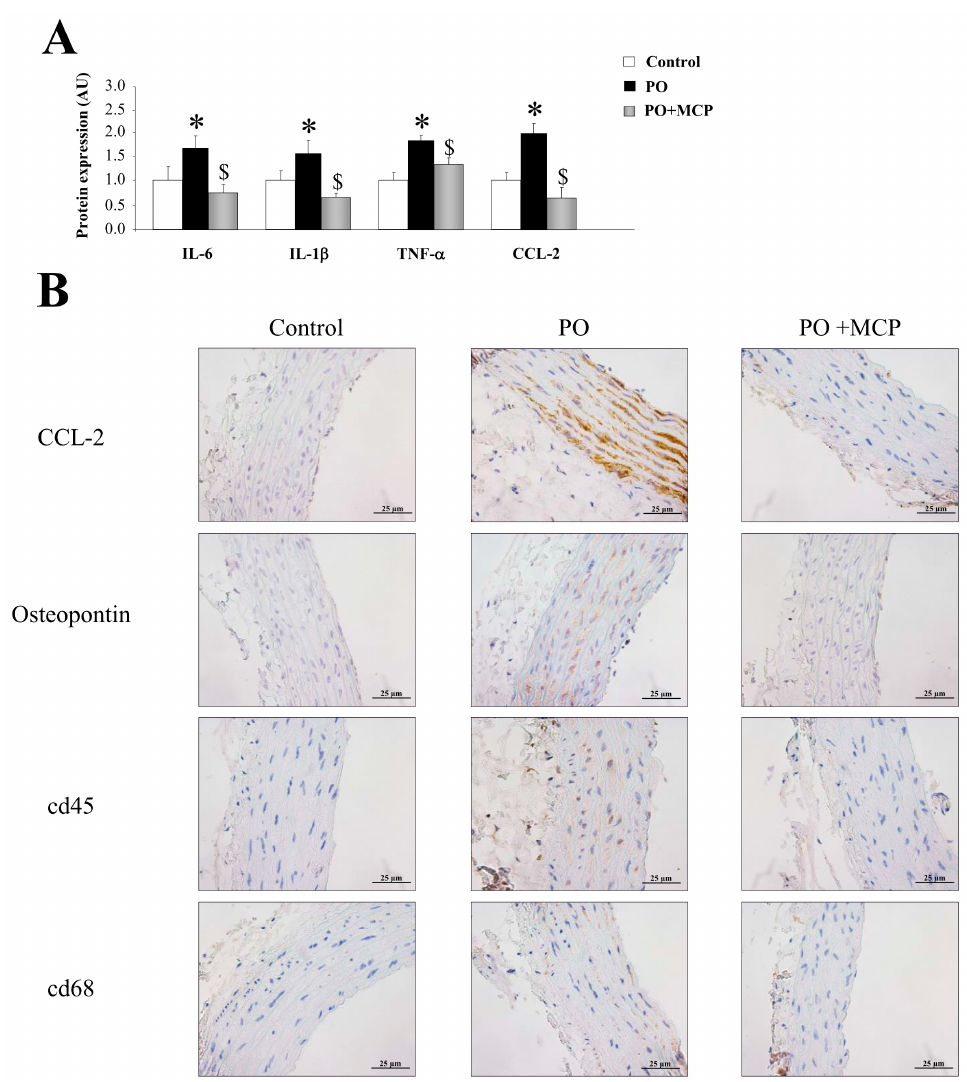
Figure 4. Pharmacological inhibition of Gal-3 reduces vascular inflammation. Normalized values of the protein levels of interleukin (IL)-6 (pg/mL), IL-1 β (pg/mL), tumor necrosis factor (TNF)- α (pg/mL), and monocyte chemoattractant protein (CCL)-2 (pg/mL) in aorta from controls, PO, and PO + MCP rats using ELISA ( A ); representative pictures of aortic sections immunostained for CCL-2, osteopontin, cd45, and cd68 ( B ). Histogram bars represent the mean ± SEM of each group of rats in arbitrary units. Magnification 40×. (Control rats, n = 7; Pressure Overload rats, PO, n = 7; and Pressure Overload rats treated with MCP, PO + MCP, n = 7). * p <0.05 vs. control group; $ p < 0.05 vs. PO group.